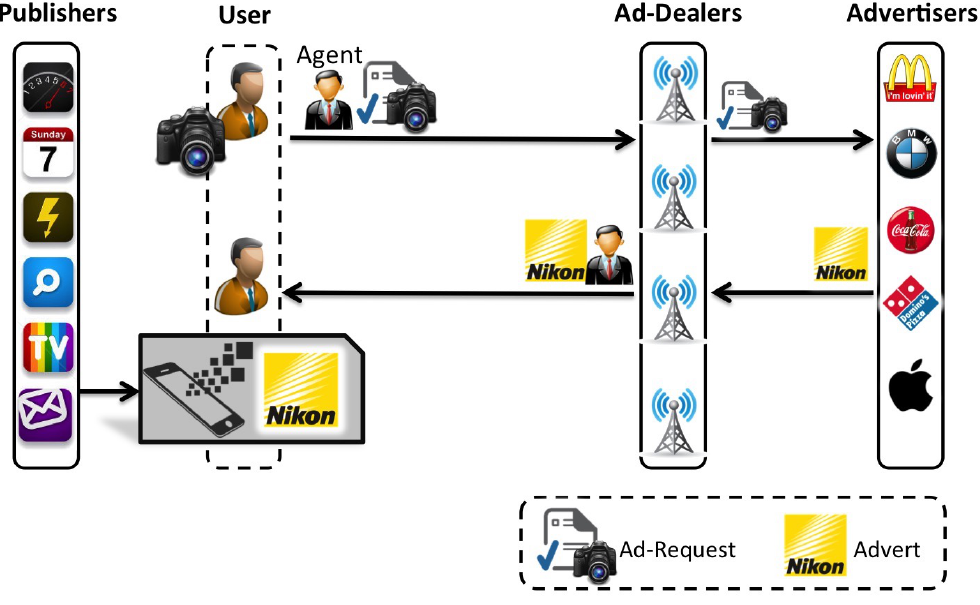
Figure 1. Decentralized advert distribution system over opportunistic